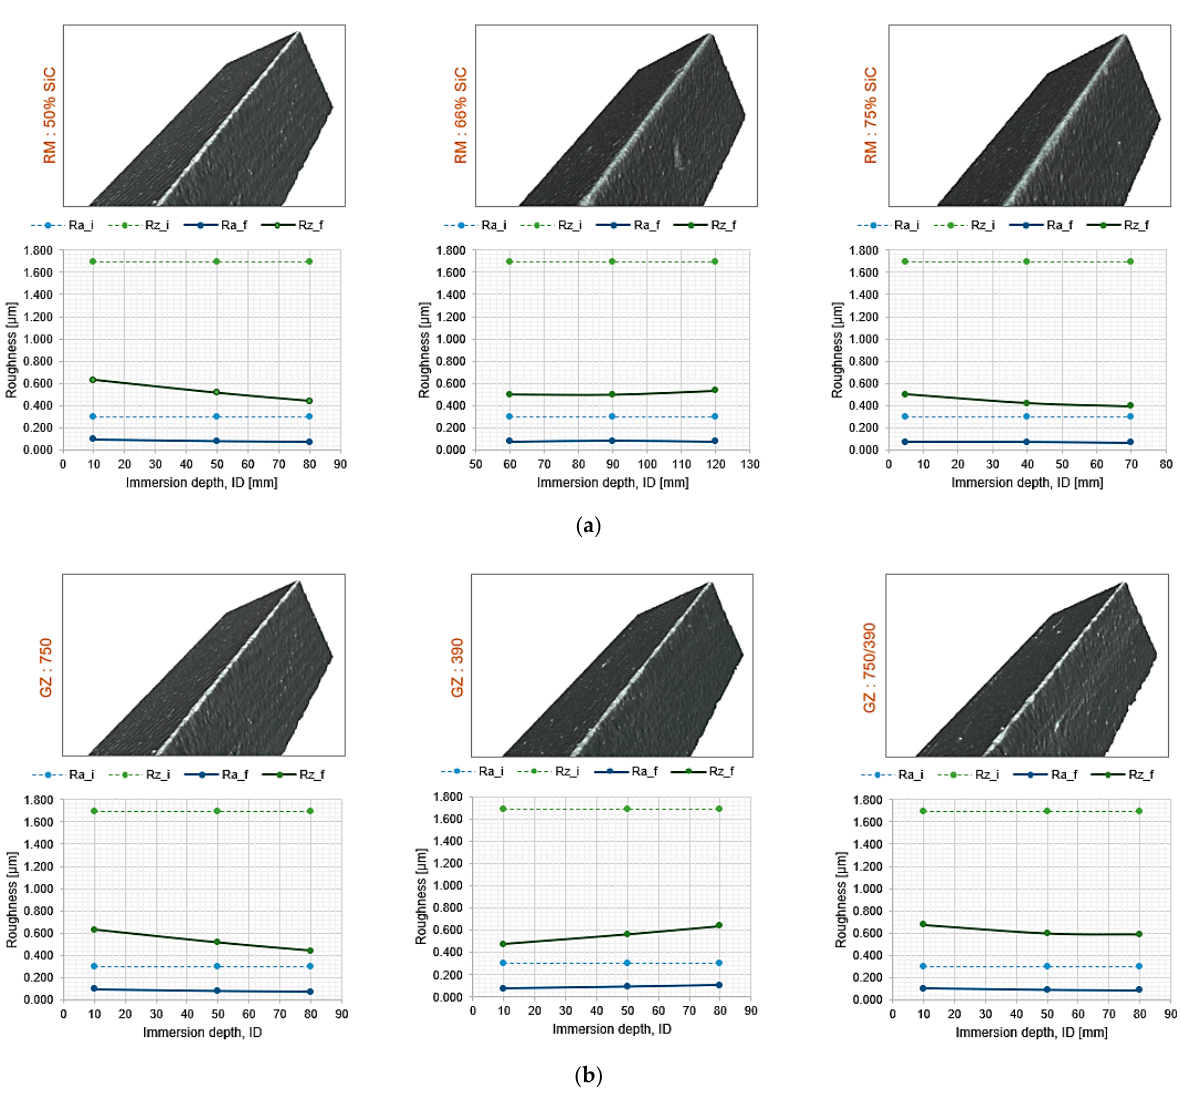
Figure 12. Behavior of the surface roughness against, ( a ) percentage of silicon carbide RM , ( b ) abrasive grain size GZ.